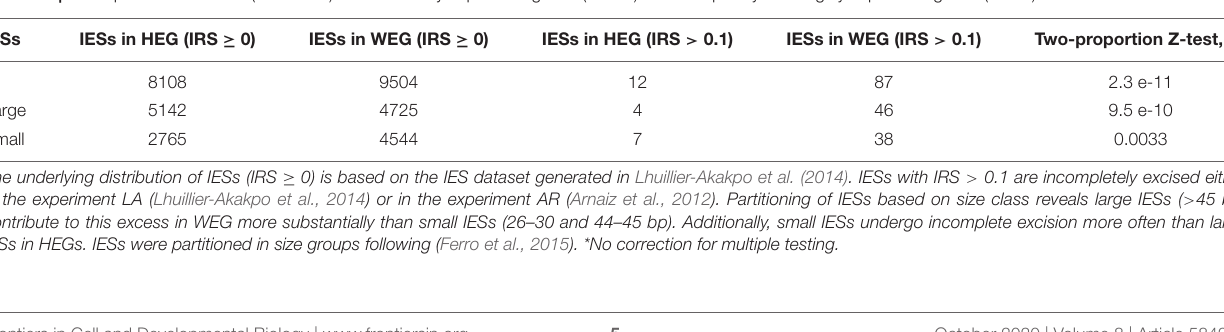
TABLE 1 | Incomplete IES excision (IRS > 0.1) affects weakly expressed genes (WEGs) more frequently than highly expressed genes